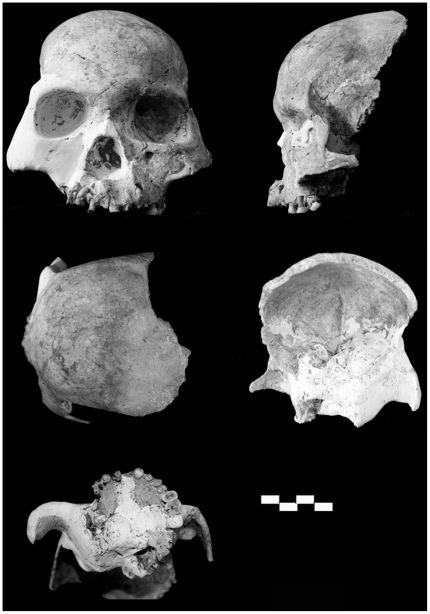
Longlin 1 partial skull (each bar = 1 cm).